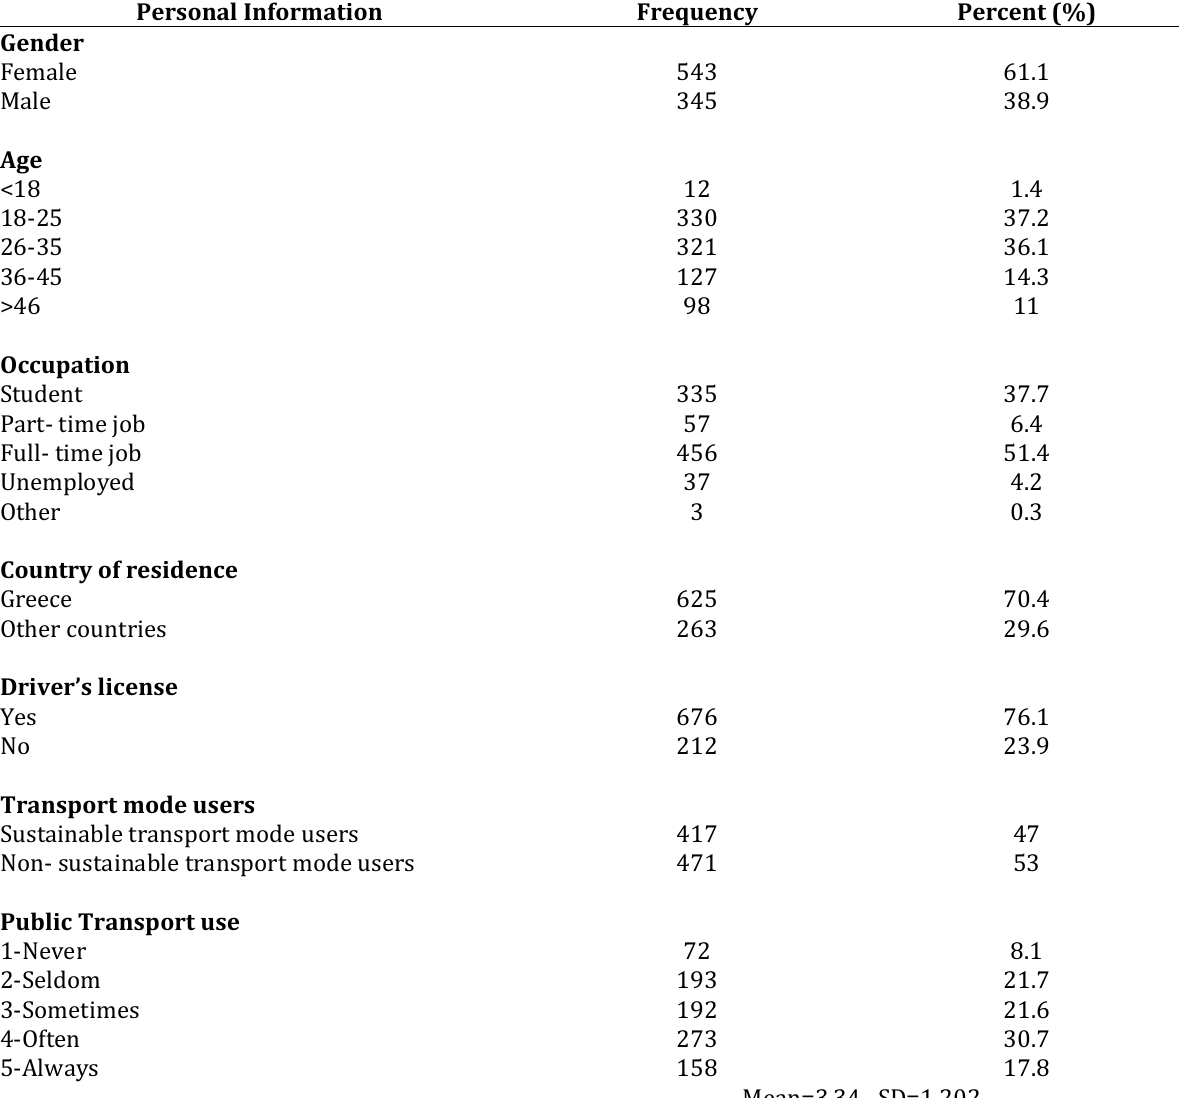
Table 1: Respondents’ personal information and travel